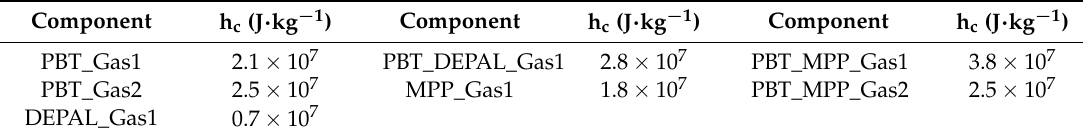
Table 5. Heats of combustion of gaseous decomposition products.